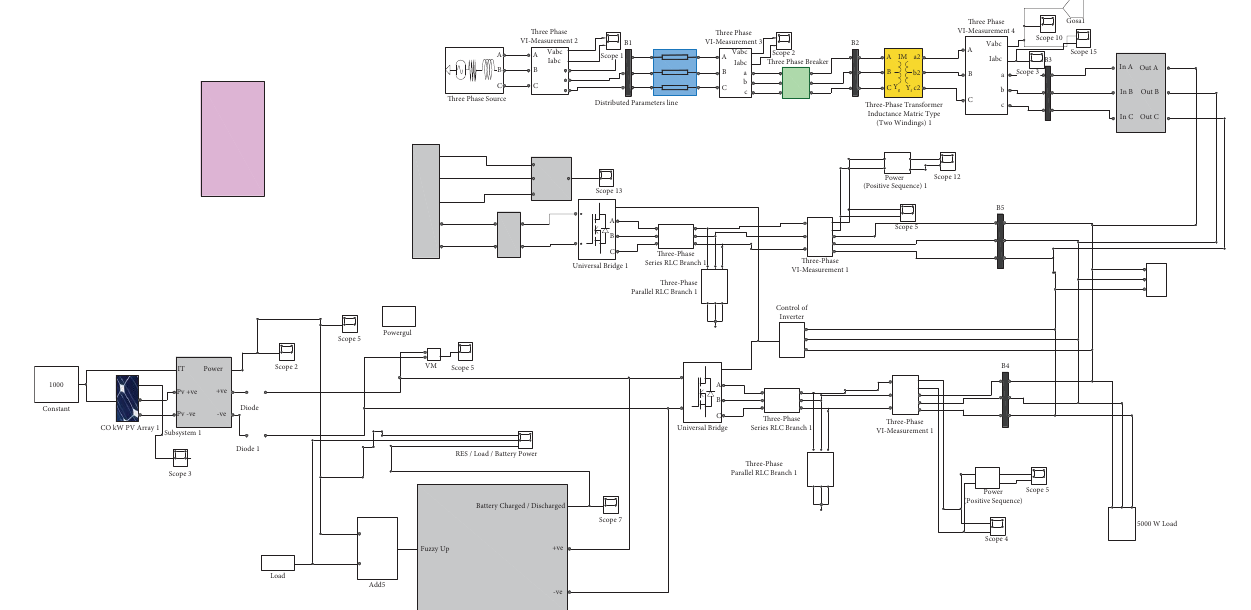
Figure 3: Te MATLAB/simulink model of HMG with the PV, battery, and fuel